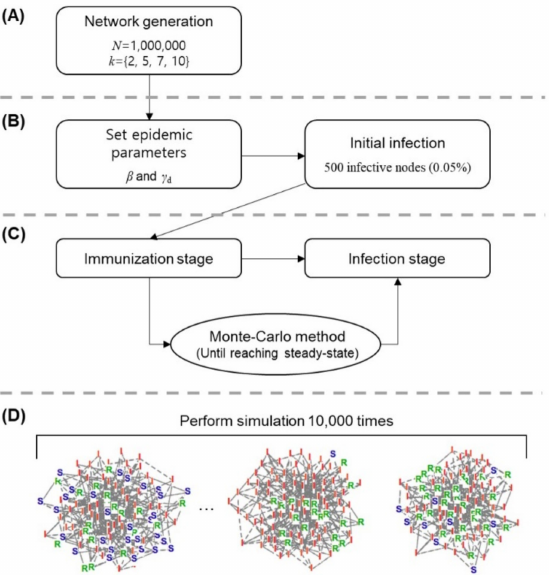
Figure 1. Overview of epidemic simulation process based on the Monte Carlo method. ( A ) We gener- ated scale-free networks for a fixed population ( N = 1,000,000) and various node degrees ( k = 2, 5, 7, and 10). ( B ) Epidemic spreading was simulated by applying a susceptible–infectious–recovered (SIR) model to the scale-free network. We set the epidemic parameters, β and γ d . β represents the spreading rate of epidemics, and γ d is the reciprocal of γ and reflects the time interval between infection and recovery. Randomly, 0.05% of nodes were initially infected. ( C ) We adapted the Monte Carlo method to determine the status of the transition from the infection node to immunization node. Repeated simulations were performed until a steady state was achieved. ( D ) For every parameter set, 10,000 simulations were